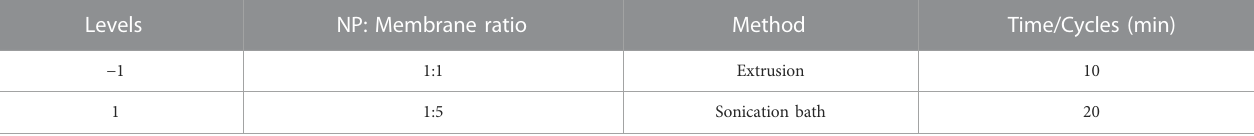
TABLE 1 Variables with respective coded levels of the fractional factorial design. Levels